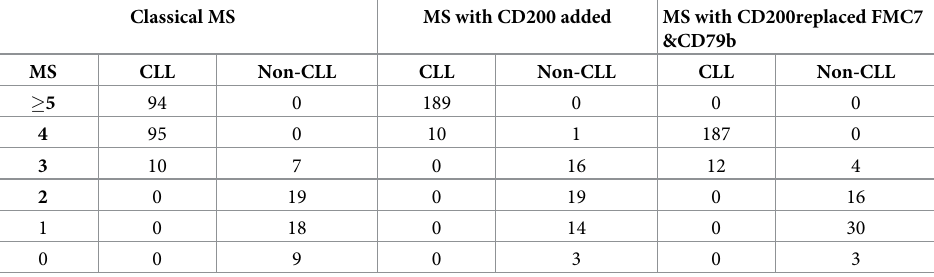
Table 4. Patients classification according to Matutes score and the alternative proposed score.